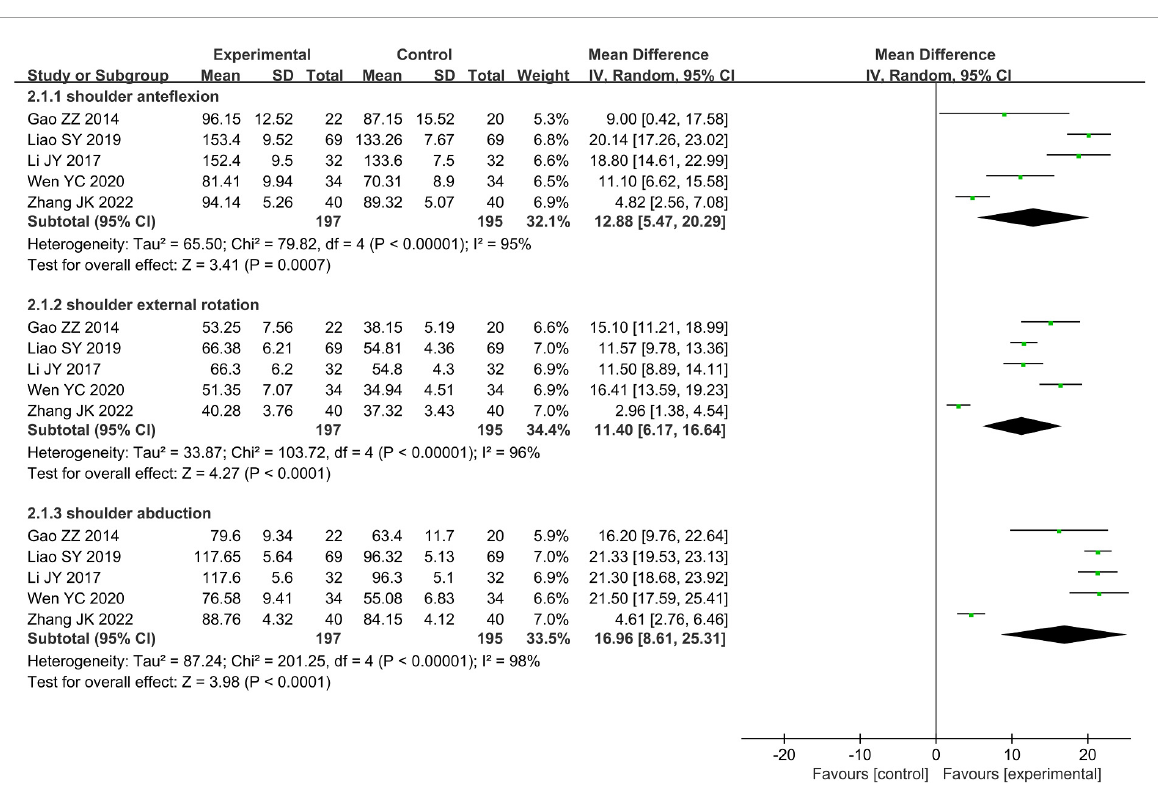
FIGURE7 Forest plot and meta-analysis of ROM of anteflexion, external rotation, and